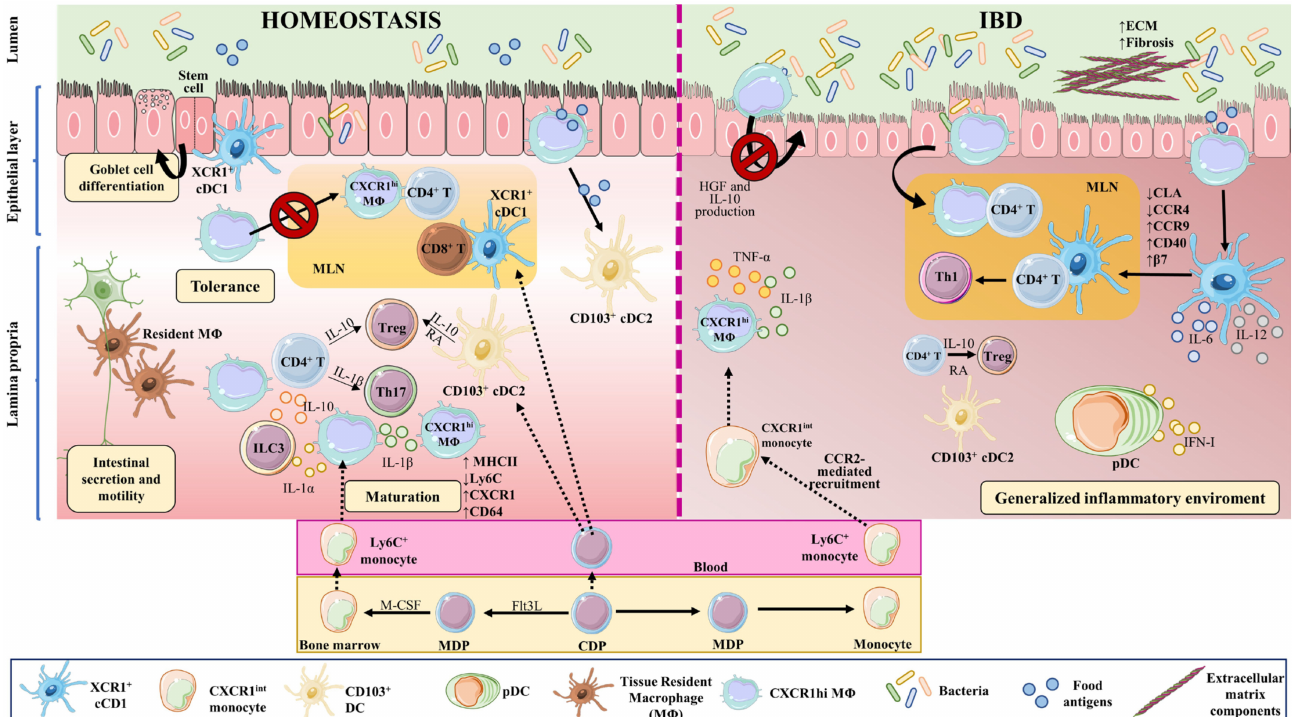
Figure 2. Macrophages and dendritic cell in homeostasis and IBD. Macrophages and DCs play important roles in homeostasis and in the development of IBD by phagocytosing cellular debris, producing cytokines, regulating tissue repair, and interacting with other cells. In the intestine, monocyte-derived macrophages (M Φ ) are more abundant than tissue-resident macrophages of embryonic origin. Both perform phagocytosis, produce cytokines, and interact with other cells. Upon weaning, bone marrow-derived monocytes egress from the circulation and extravasate into the tissue, where they undergo differentiation and maturation (downregulation of Ly6C, production of MHCII, and increased expression of CX3CR1). In homeostasis, tissue-resident macrophages in the muscularis externa interact with enteric and myenteric neurons controlling intestinal secretion and motility, while in the lamina propria, macrophages provide signals to intestinal stem cells that give rise to goblet cells, Paneth cells, and intestinal epithelial cells. These macrophages also modulate T cell activities and functions, via the secretion of IL-10 for Tregs and IL-1 β for Th17 cells. In addition, they affect ILC3 cells through the production of IL-1 α and IL-1 β . The migration of antigen-loaded CX3CR1 high intestinal macrophages to mesenteric lymph nodes is impaired by intestinal microbiota, thus affecting antigen presentation to T cells and effectively sustaining tolerance towards commensal bacteria. On the other hand, XCR1 + DCs play a tolerogenic role upon recognizing commensal bacterial components, while CD103 + cDC2s seem to be important for initiating oral tolerance through their capacity to generate RA and IL-10. In IBD, large numbers of Ly6C high inflammatory monocytes are recruited to the intestine in a CCR2-dependent manner, becoming pro-inflammatory effector cells. These inflammatory macrophages produce TNF α , IL-6, and iNOS, and directly cause the onset and development of fibrosis through a disproportionate accumulation of ECM. The intestinal microbiota is impaired during chronic colitis, and CX3CR1 high macrophages can change their habits and migrate to lymph nodes. CD103 + cDC numbers are significantly reduced in the inflamed and uninflamed intestine in IBD; however, activated DCs can release inflammatory cytokines, in addition to type I IFN produced by pDCs. All these phenomena contribute to a generalized inflammation. Part of the figure was generated by using pictures from Servier Medical Art. Both tissue-resident and monocyte-derived macrophages perform the typical In the intestine, monocyte-derived macrophages are more abundant than